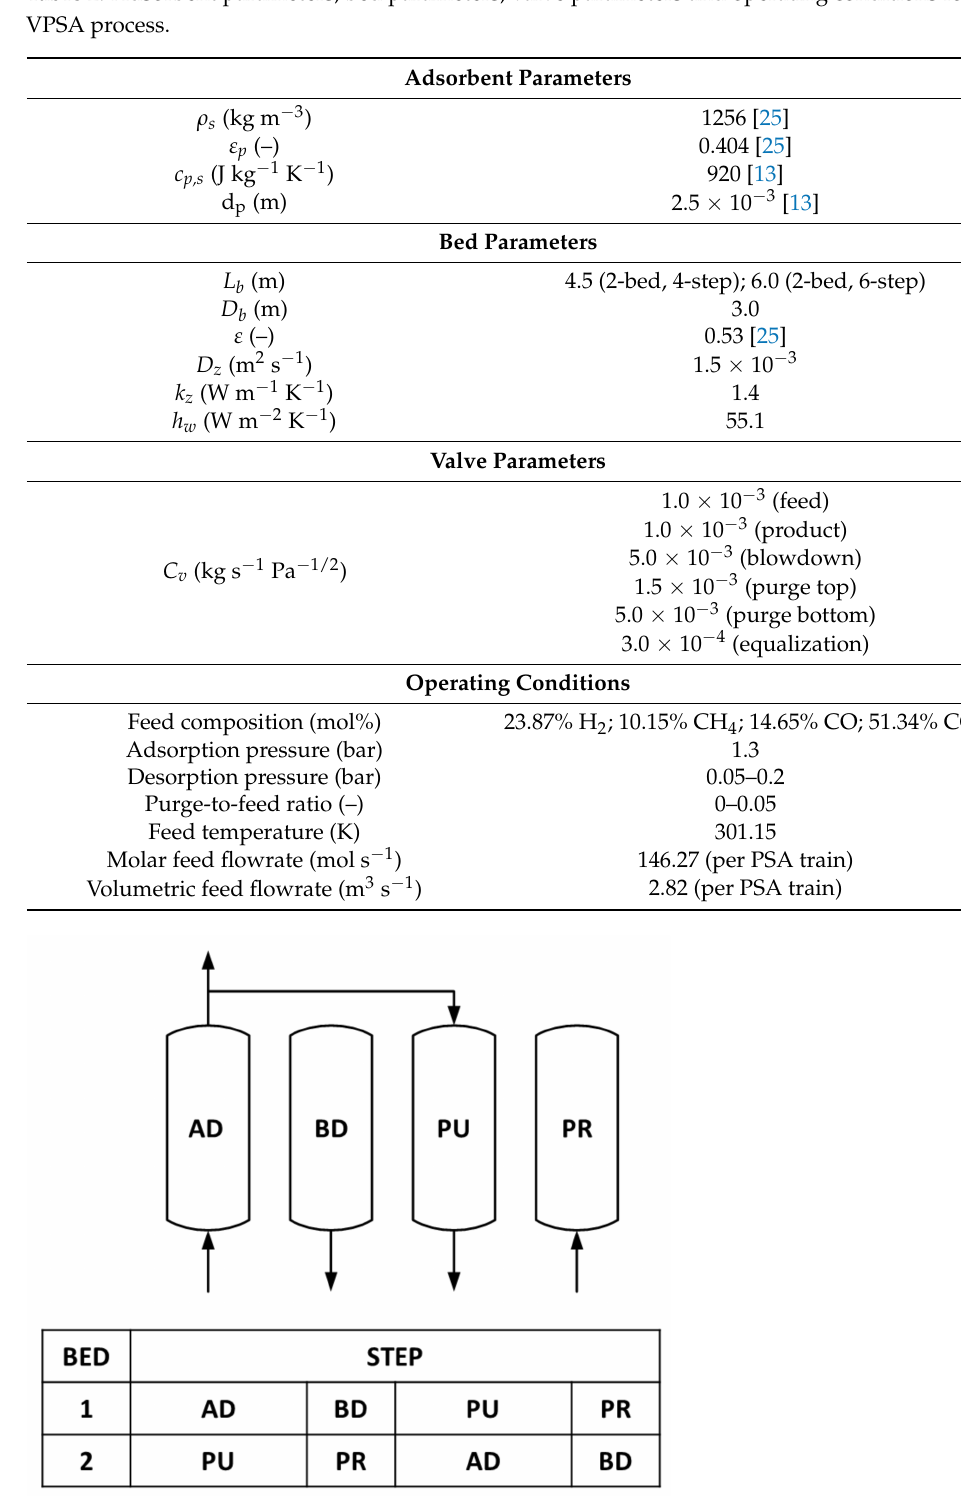
Figure 2. Configuration of the 2-bed, 4-step Skarstrom cycle (AD: Adsorption, BD: Blowdown, PU: Purge, PR: Feed pressurization; t AD = t PU = 250 s, t BD = t PR = 50